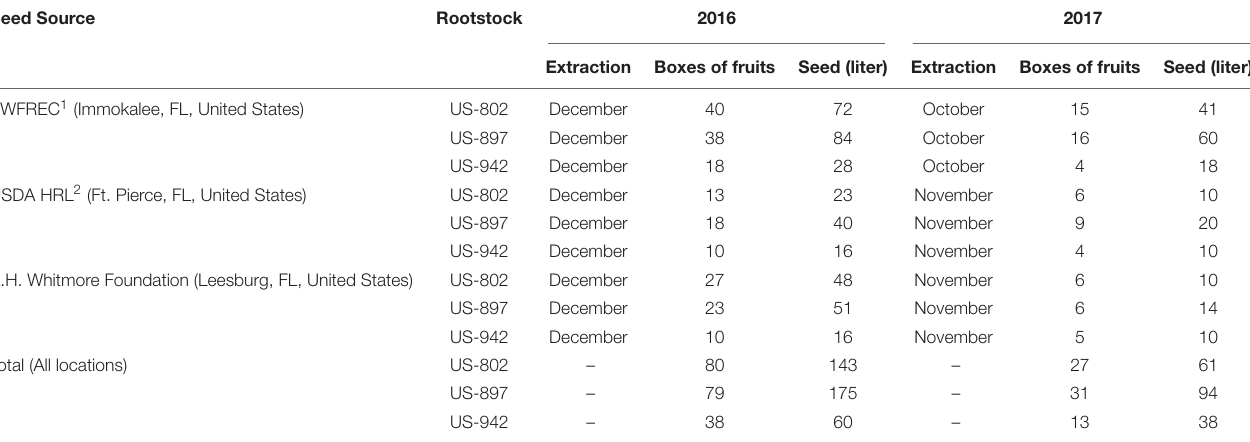
Seed Source Rootstock 2016 2017 Extraction Boxes of fruits Seed (liter) Extraction Boxes of fruits Seed (liter) SWFREC 1 (Immokalee, FL, United